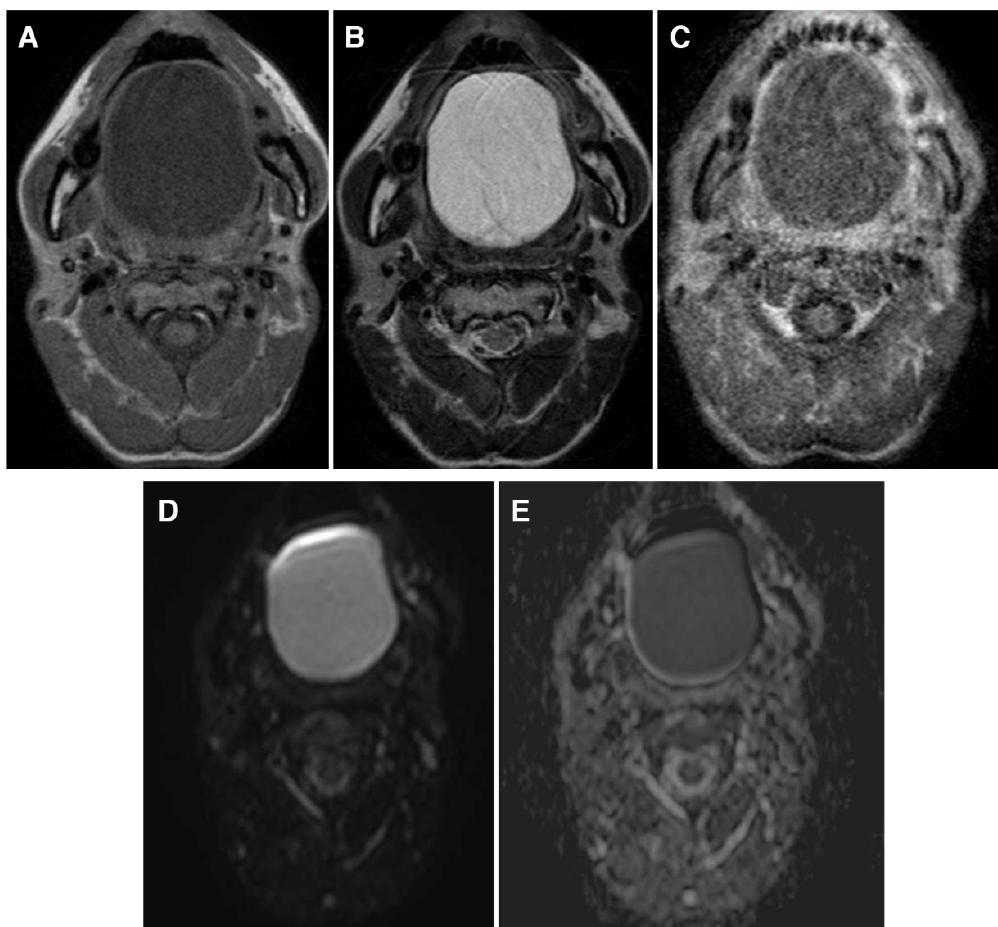
Figure 3. MRI findings. ( A ) Low signal at T1. ( B ) High signal at T2. ( C ) Contrast effect only around lesion. ( D ) Diffusion weighted image. ( E ) Apparent diffusion coefficient image.